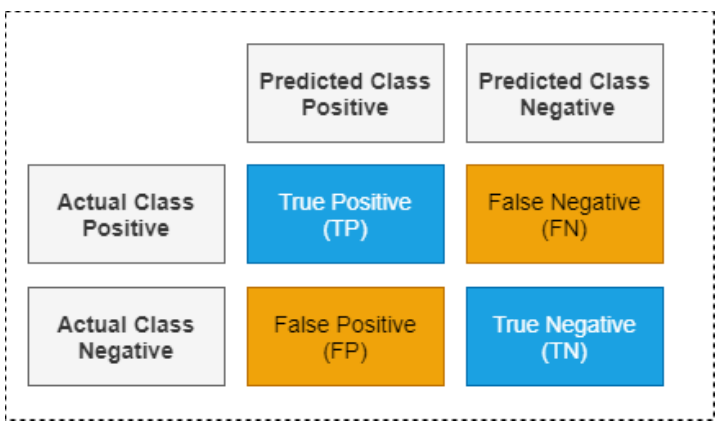
Figure 5. Confusion matrix.